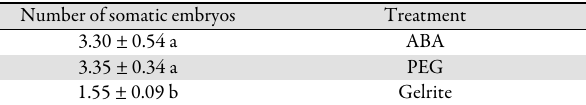
Gelrite can help to slow down the osmotic potential in the medium and thus improve the quality of somatic embryos, by promoting normal differentiation (Stasolla et al .,